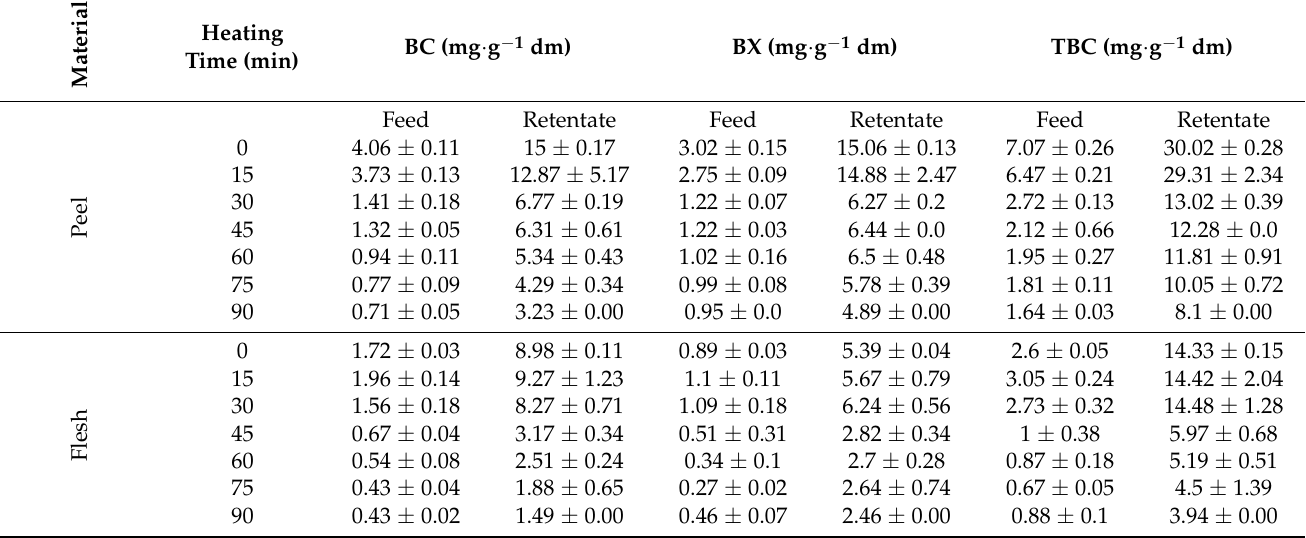
Table 4. Variation of betalains in the feeds and concentrates after heating at 70 ◦ C for 90 min.